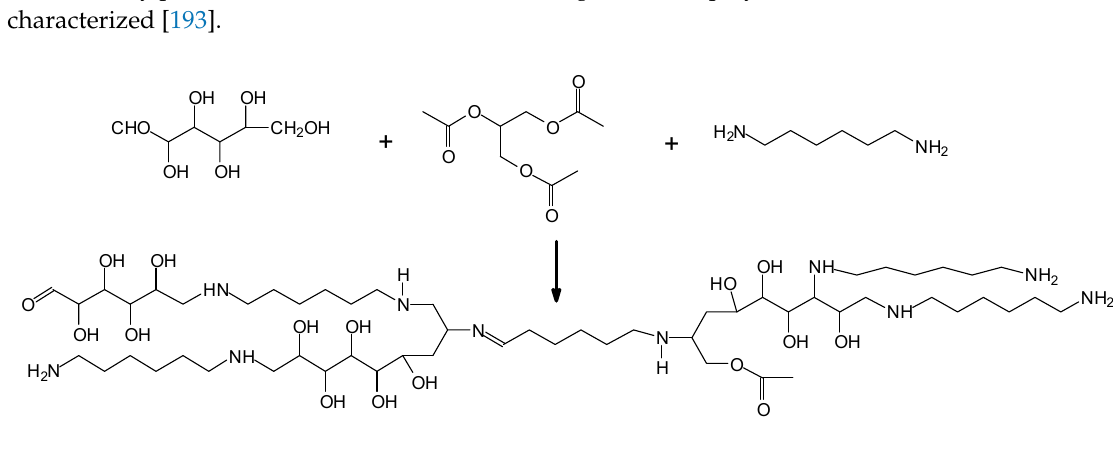
Figure 6. Example of a mixed higher molecular weight oligomer leading to adhesive crosslinking formed, among others, in the new adhesive system derived by the reaction of glucose or sucrose with triacetin and hexamethylene diamine [194].